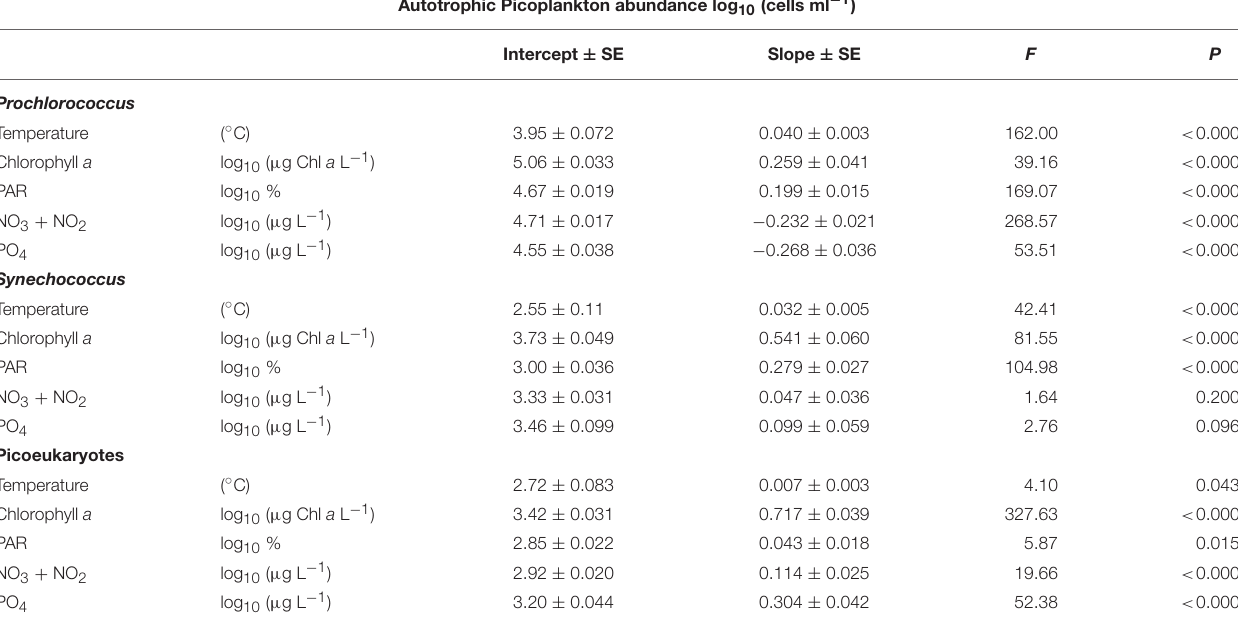
TABLE 2 | Summary of the parameters and statistics for the linear relationships between autotrophic picophytoplankton abundance and water properties in the Subtropical and Tropical